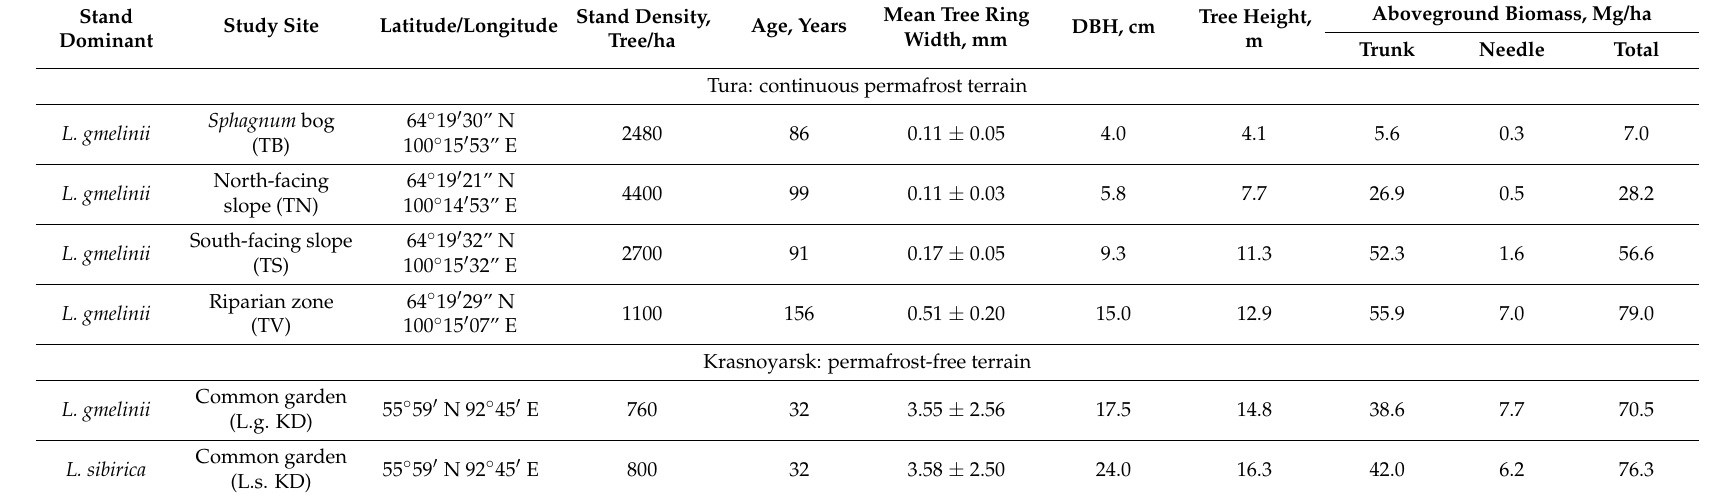
Table 1. Site and tree stand characteristics of the study sites in Central Siberia.